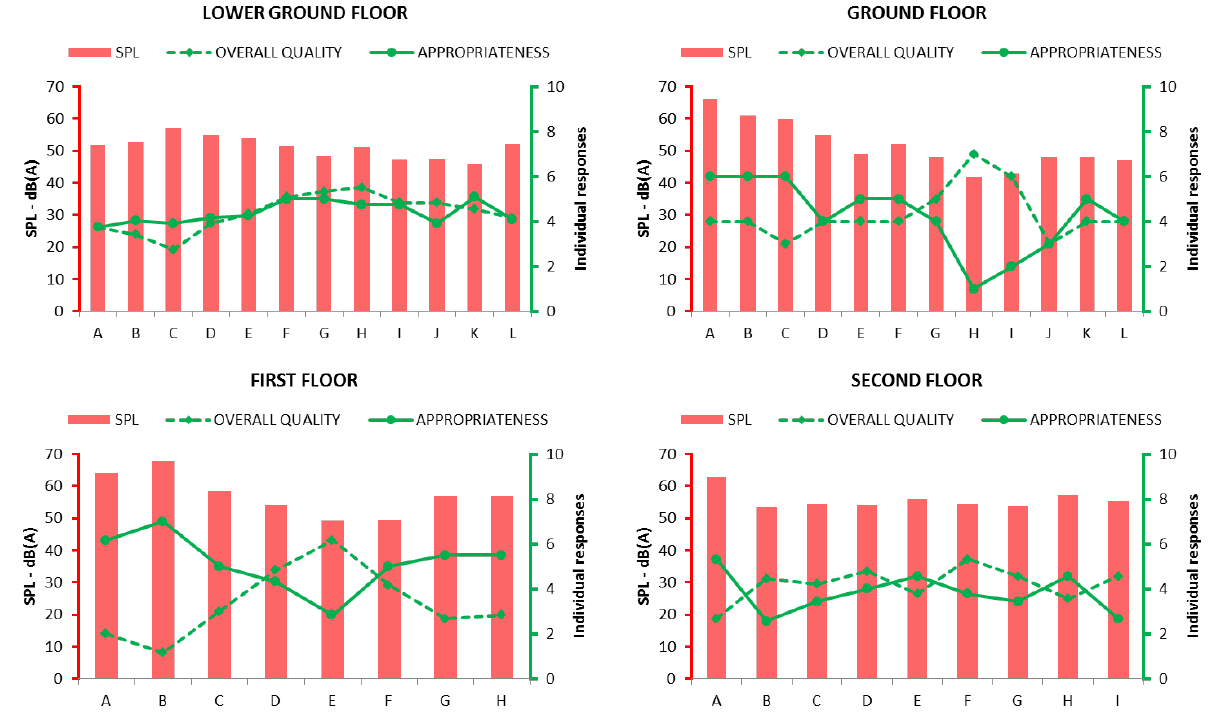
Figure 6: Ratings of the overall quality and appropriateness of soundscapes along the soundwalks on each floor with Mean values of SPL